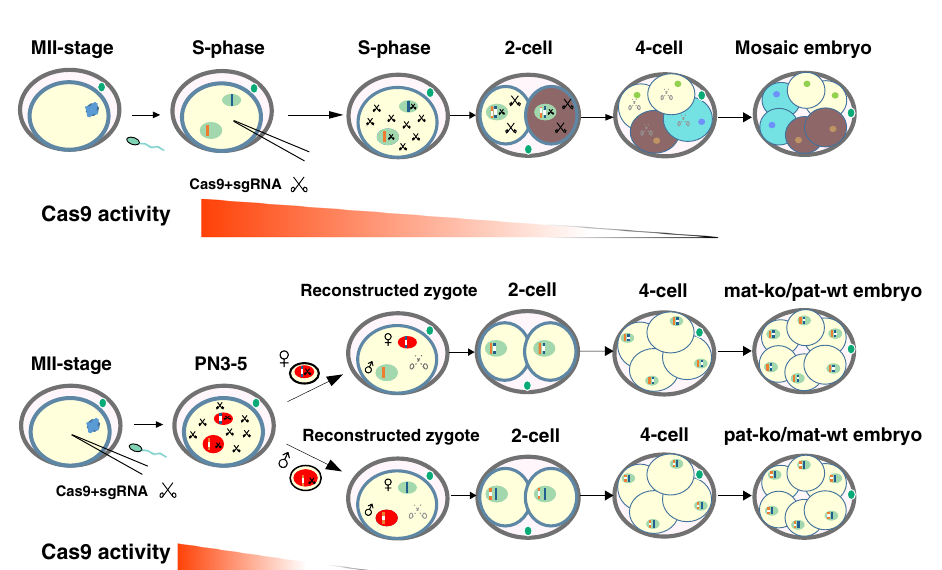
Fig. 5 Model illustrating Cas9 activity during the development of embryos performed by traditional zygote injection methods in the upper panel and Past-CRISPR in the lower panel. Solid scissors represent suf fi cient amounts of Cas9 with targeting activity, and dashed scissors represent low amounts of Cas9 with weak or no targeting activity. Different colors of different blastomeres represent different mutation